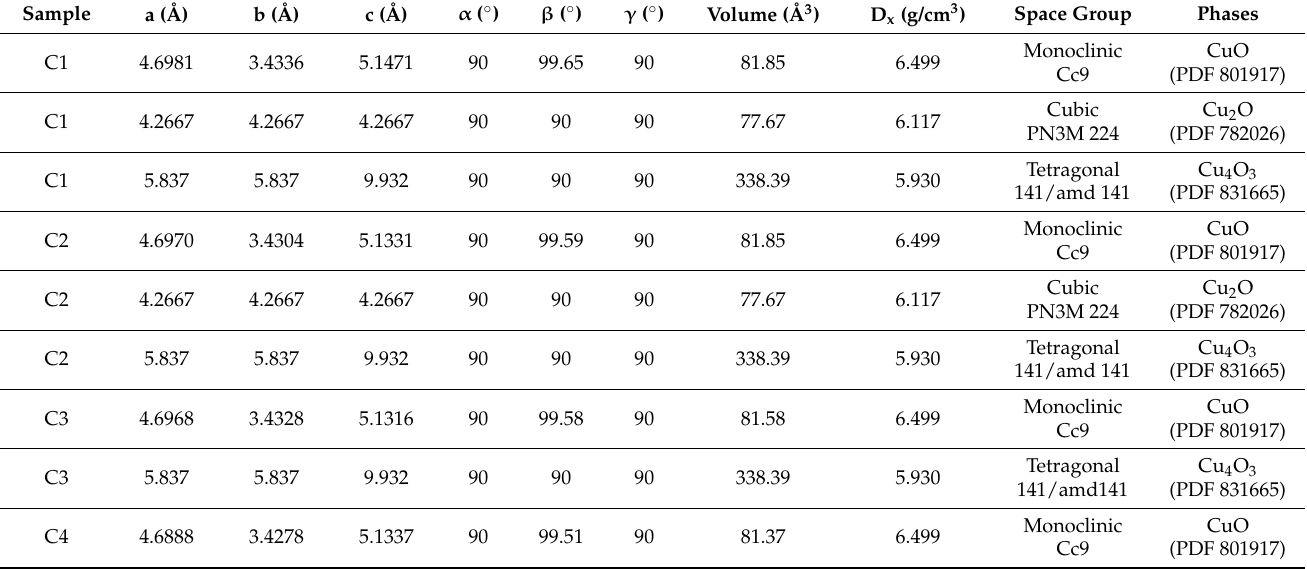
Table 3. The C1, C2, C3, and C4 samples, crystal parameters, identified phases, and their PDF